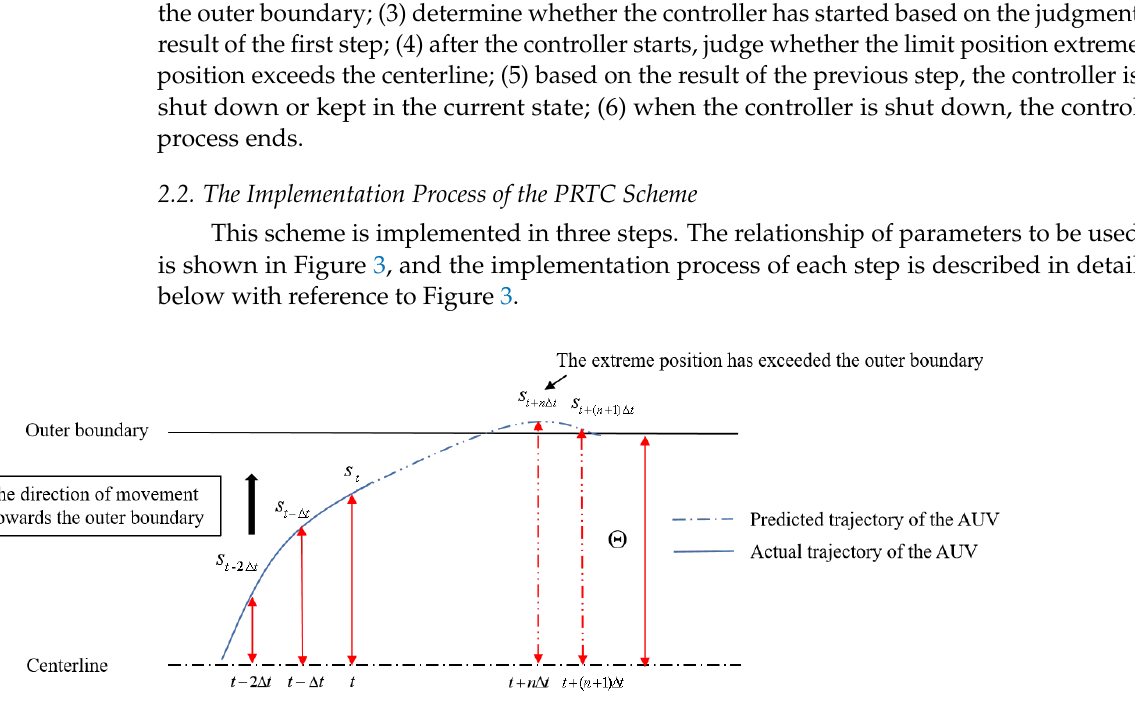
Figure 2. Flow chart of the PRTC scheme.